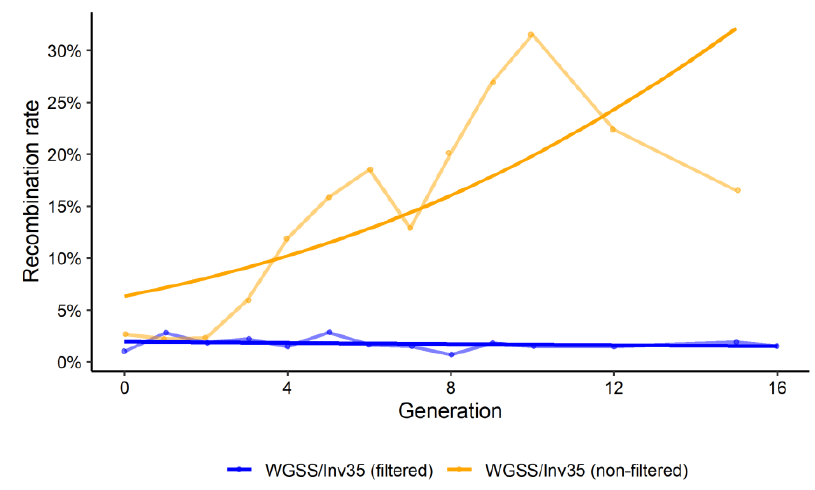
Figure 1. Recombination rate of the WGSS/Inv35 strain over 16 generations under filtering and non- filtering conditions. Statistical analysis was carried out using a GLM with binomial distribution and indicated significant differences between filtered and non-filtered conditions. The lighter lines indi- cate the means of the experimental data, whereas the darker lines indicate the generalized linear model fitted curve for the binomial distribution.